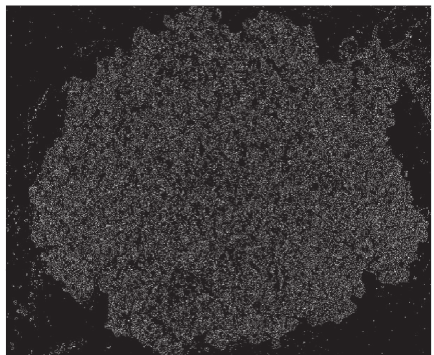
Figure 5: Image processed by the Canny operator.